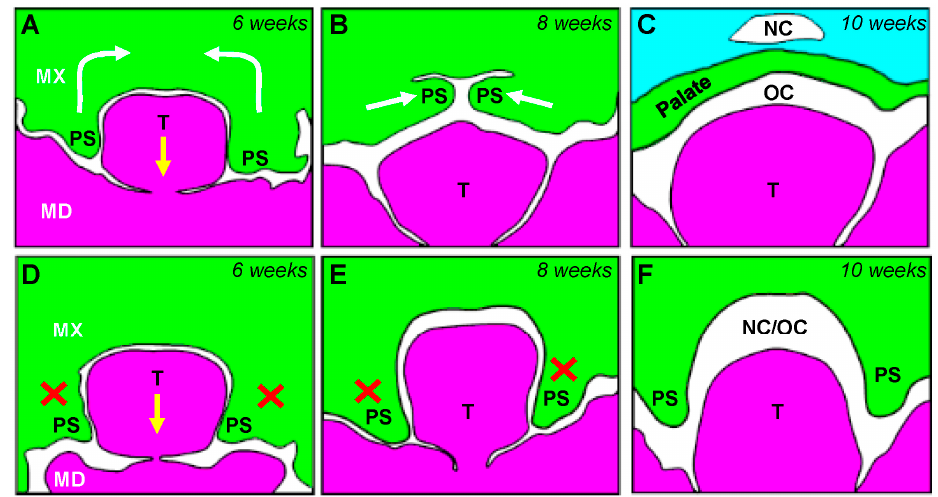
Figure 2. Palatogenesis and development of palatal clefts. The palatal shelves, outgrowths of the maxillary processes, initially form and are directed ventrally, lateral to the developing tongue ( A ). As the embryo develops, the tongue migrates ventrocaudally and the palatal shelves migrate dorsolaterally (arrows in A ). By 8 weeks of human development, the palatal shelves have begun to migrate towards each other ( B ), and following apposition and fusion, form the secondary palate by 10 weeks, ensuring clear separation between the oral cavity (OC) and, at the anterior end, the nasal cavity (NC; C ). Although palatal clefting has numerous diverse aetiologies, mechanistically, the palatal shelves remain similarly oriented ventrally at 6 weeks of development ( D ), but fail to elevate (crosses in D , E ). This ultimately results in a failure of secondary palate formation, and a continuous passage between the oral and nasal cavities (at the anterior portion of the face; F ).